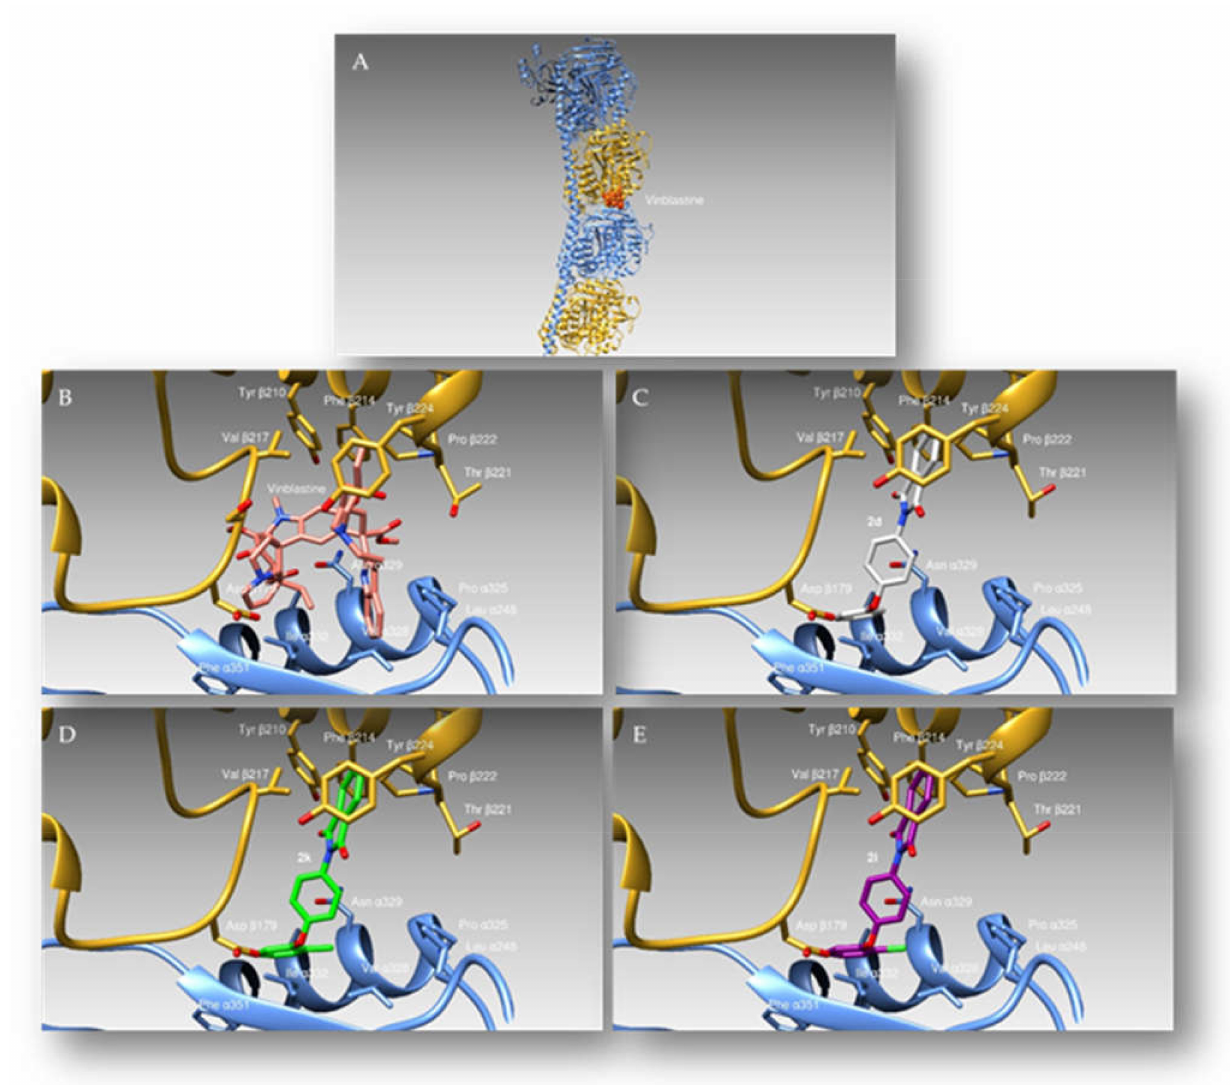
Figure 6. A schematic representation of the tetrameric 2 α 2 β tubulin structure. α chain is reported as cyan ribbons, β as Golden ribbons ( A ). Compounds 2d , 2k and 2i superpose to vinblastine binding site ( B ). ( C – E ) report the compounds 2d , 2k and 2i , respectively, drawn as white, green and dark magenta sticks, bound to the vinblastine binding task of the